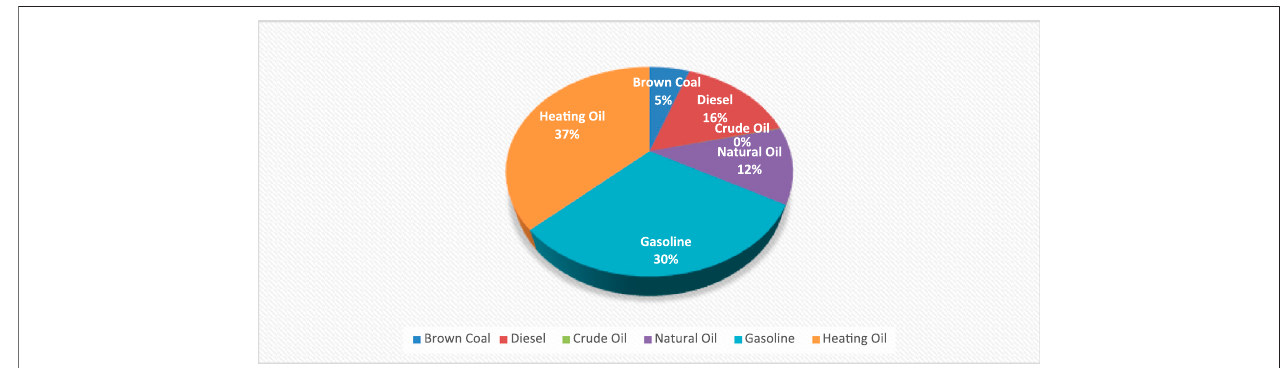
FIGURE 2 | Energy future prices volatility (in percentage).